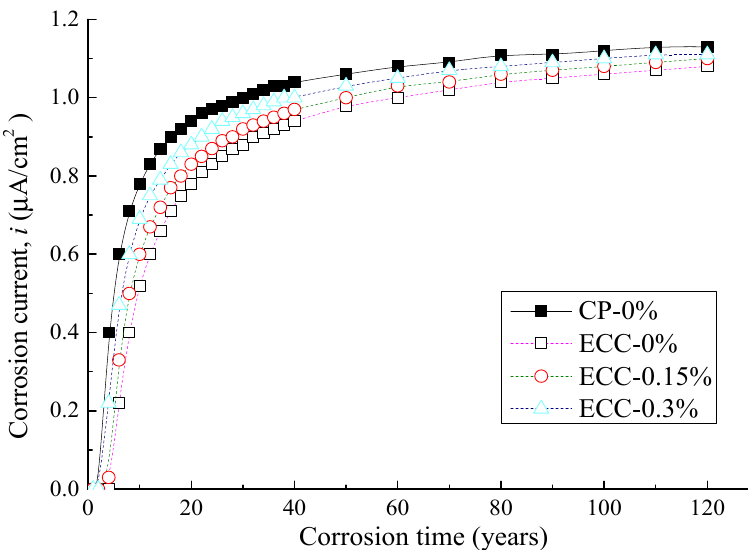
Figure 13. Corrosion rates of steel rebar in soil nails calculated from the empirical equation.